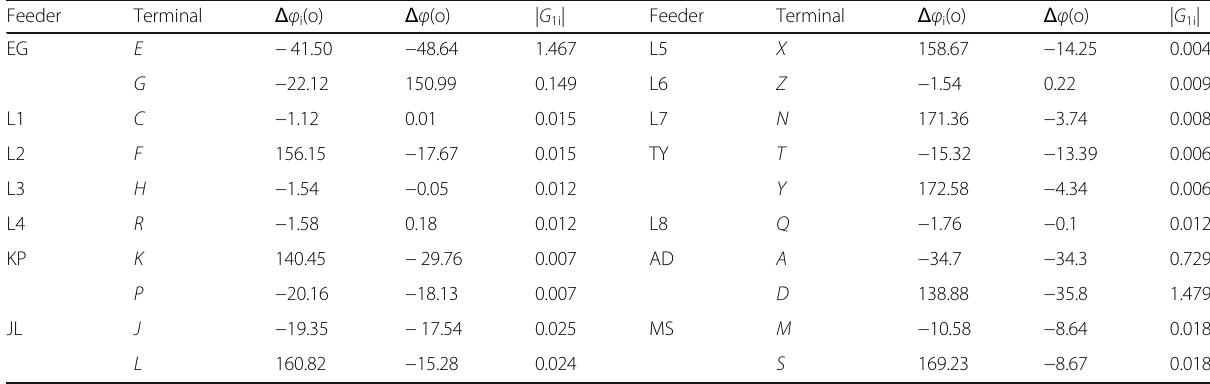
Table 5 Measured admittance results when the F1 fault occurs